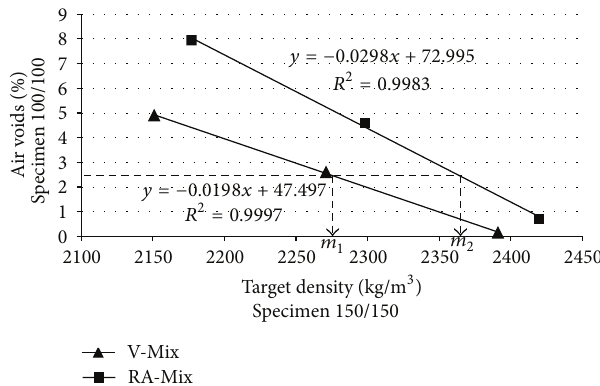
Figure 9: Relationships of the desired air voids content of the 150/150 specimen to be compacted and the target density to be set on the gyratory compactor.